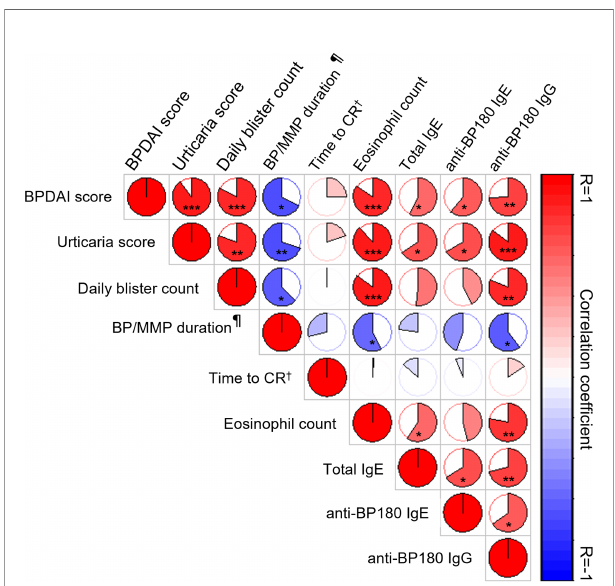
FIGURE 5 | Graphical representation of Spearman correlation matrix between clinical activity and immunological variables at baseline and outcomes. Red and blue colors indicate positive and negative correlations, respectively; the lighter the color, the less signi fi cant the corresponding correlation. The fi lled fraction of the circle in each pie chart corresponds to the absolute value of the associated Spearman correlation coef fi cient ( r ). * p < 0.05, ** p < 0.01, *** p < 0.001, ¶ before omalizumab, † Time to complete